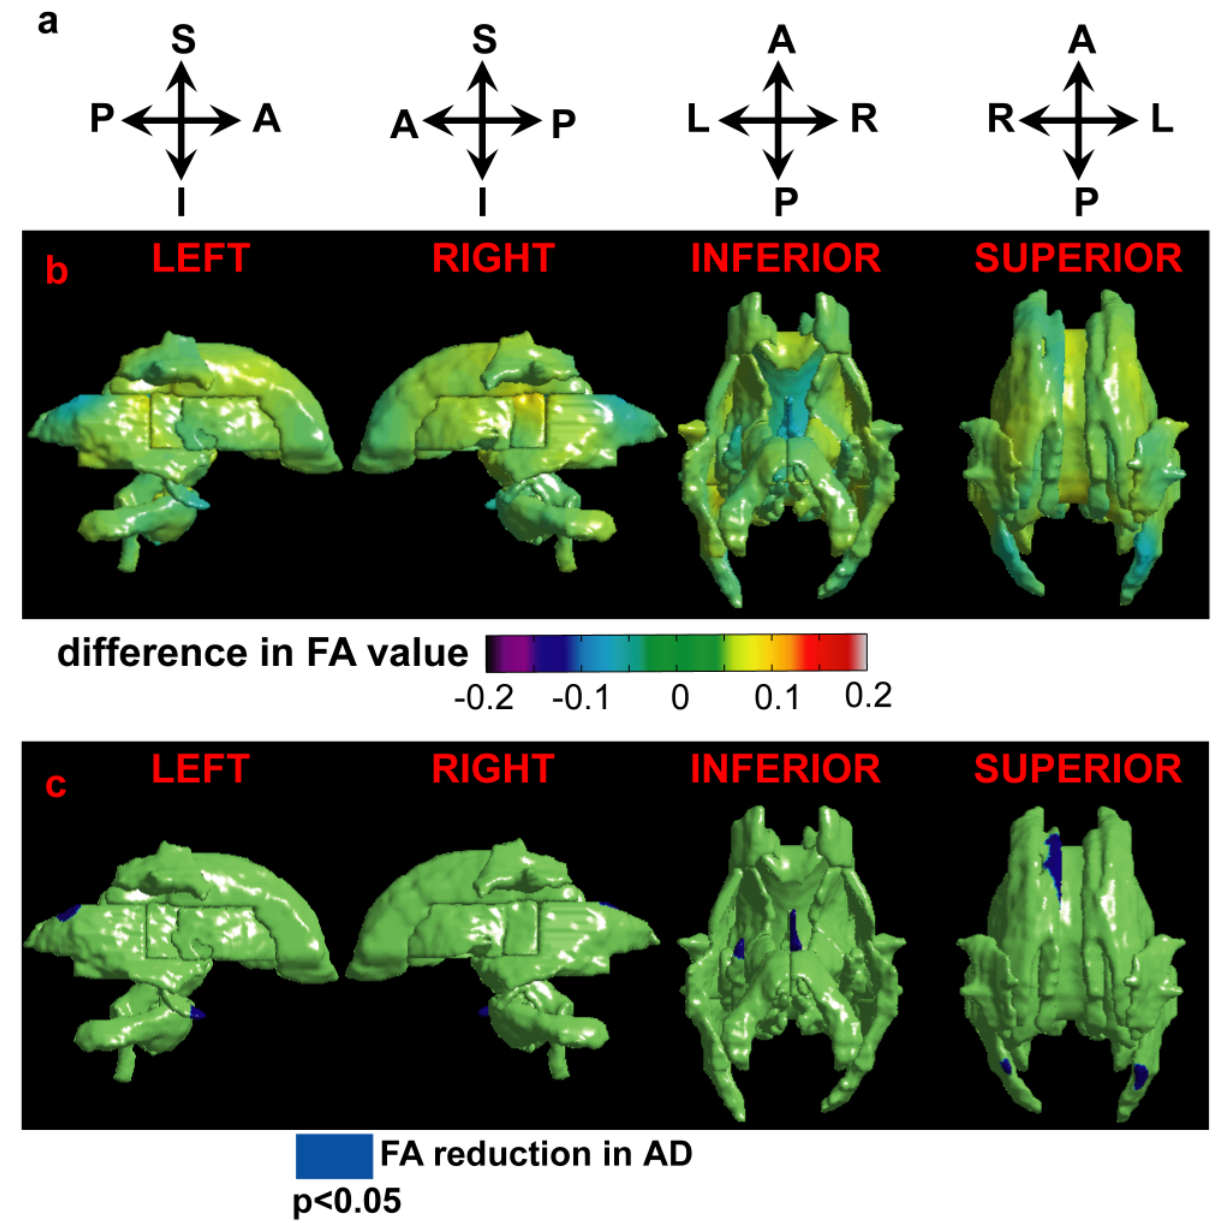
Figure 4. FA maps of the white matter tracts. Row (a) illustrates the anatomical orientation of the corresponding column. Row (b) shows the group difference in the FA map between the healthy control subjects and patients with AD. Warm color denotes regions with increased FA in the AD group; while cool color represents regions with reduced FA in the AD group. Row (c) illustrates FA abnormalities in the patients with AD relative to the healthy control subjects. Blue denotes the regions with significant FA reduction in the AD group compared with the control group. Left, right, inferior, and superior views are respectively illustrated from the left to the right.